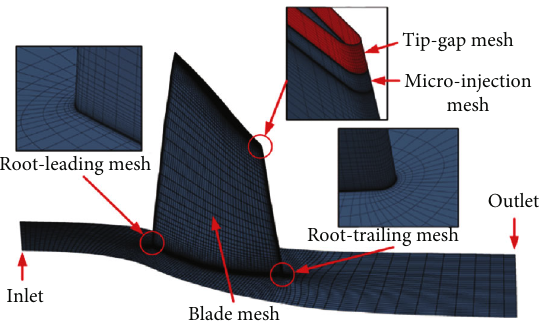
Figure 4: Computational domain.